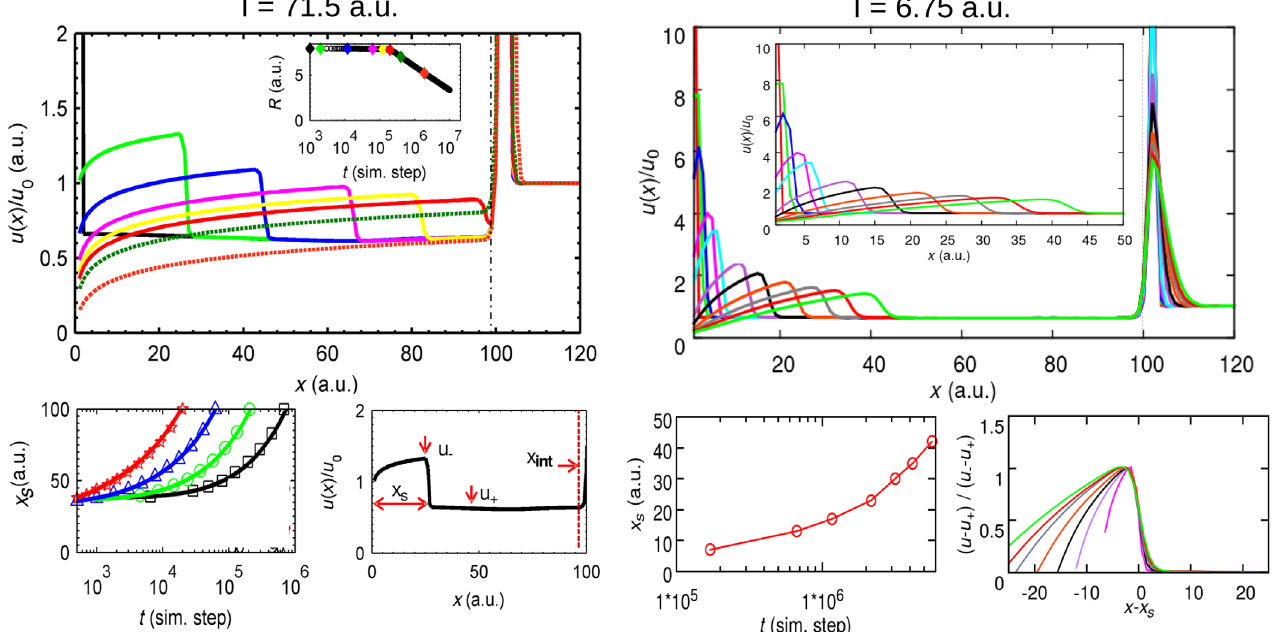
FIG. 11. Shock-wave dynamics for two different applied currents, which differ by nearly an order of magnitude. The lower-current case (right panel) corresponds to applied voltages comparable to the experimental ones, and the higher-voltage cases (left panel, same as Fig. 3) show similar shock-wave dynamics. The two lower-right panels demonstrate that (i) the propagation of the shock-wave front remains qualitatively the same as for higher applied currents, and (ii) the collapse of the snap shots of successive profiles indicates the formation of the shock